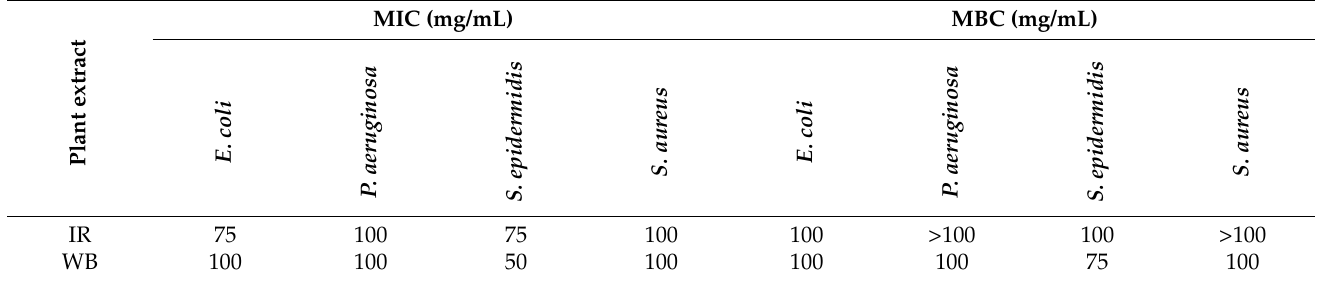
MIC and MBC values of Eryngium creticum leaf extracts against Escherichia coli , Pseudomonas aeruginosa , Staphylococcus epidermidis , and Staphylococcus aureus